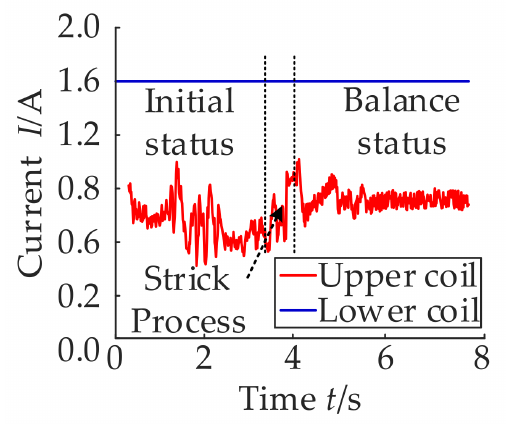
Figure 16. Current of coil by test when K p =